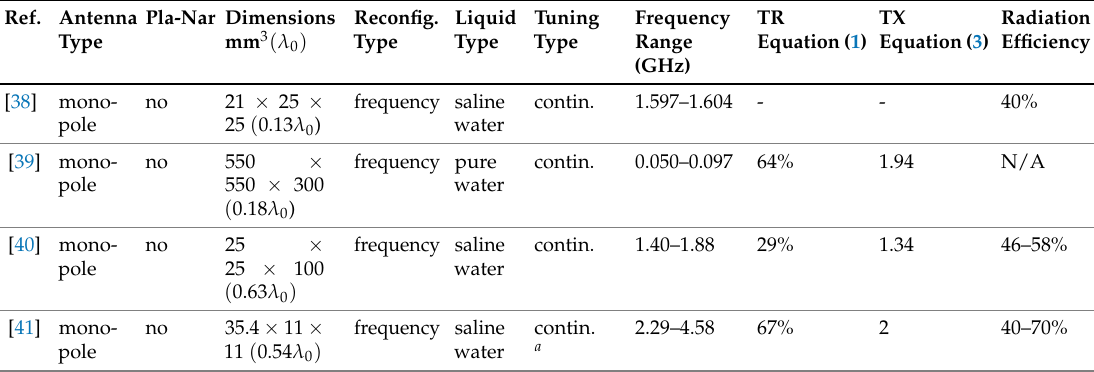
Table 1. Basic liquid-based monopole